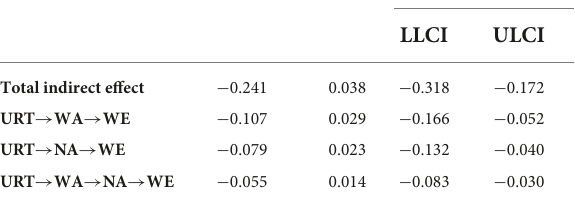
TABLE 5 Results of bootstrap test for mediating effects.